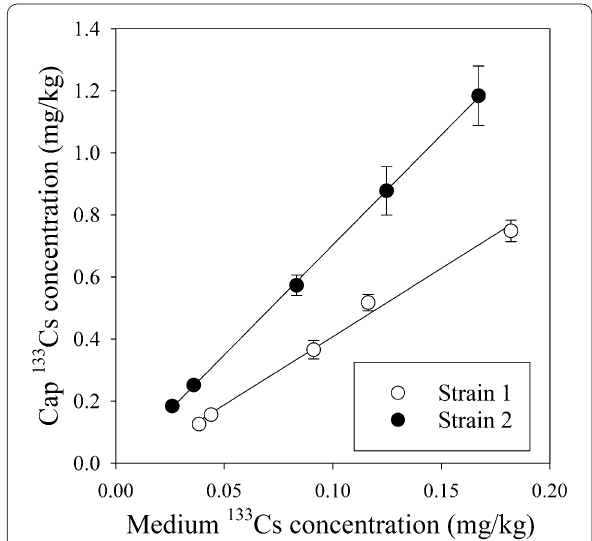
Fig. 3 Relationship between the 133 Cs concentrations in the cap and sawdust medium. The error bars above and below each point indicated the standard deviation ( n